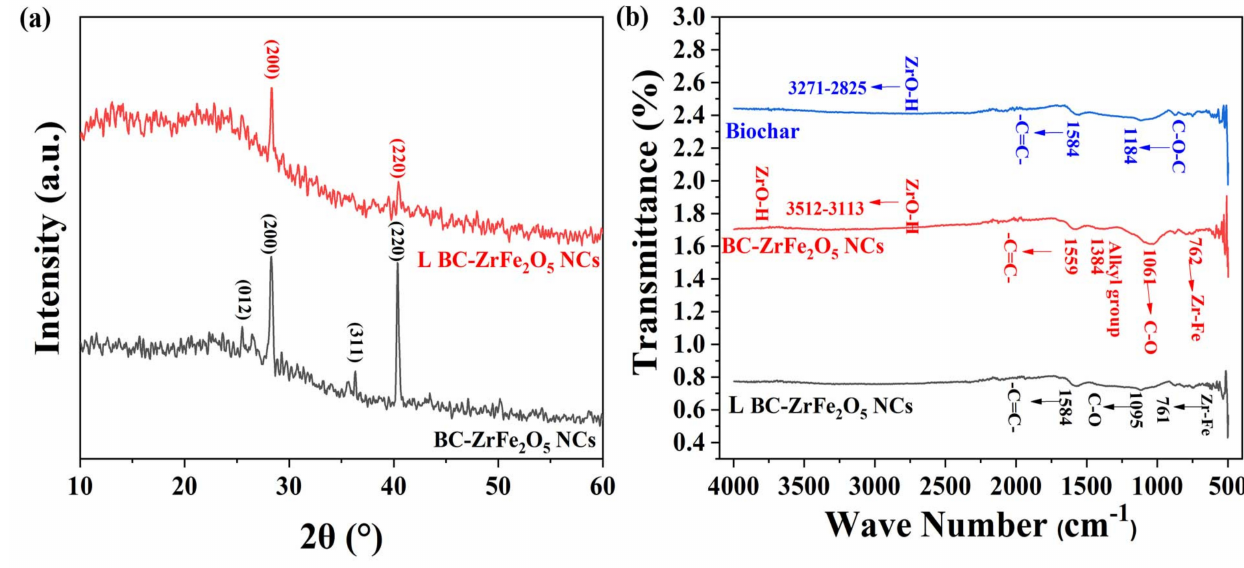
Figure 3. ( a ) XRD pattern of native BC-ZrFe 2 O 5 NCs and dye-loaded BC-ZrFe 2 O 5 NCs, ( b ) FT-IR spectrum of Biochar, BC-ZrFe 2 O 5 NCs and dye-loaded BC-ZrFe 2 O 5